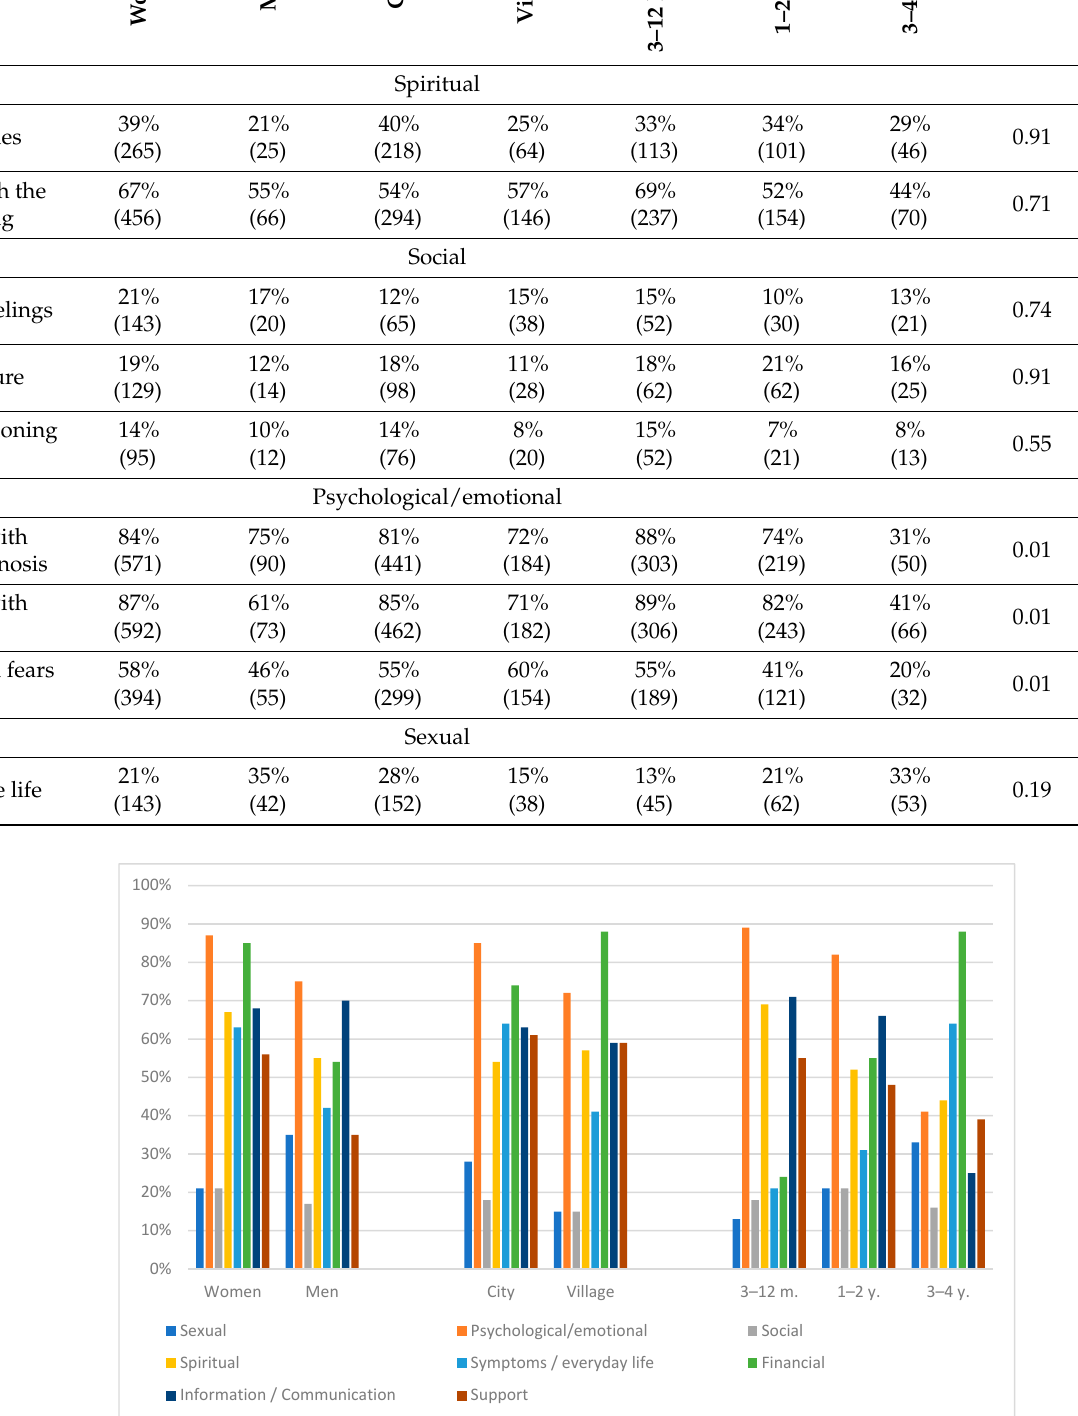
Figure 1. Moderate and high parents’ needs: sex, place of residence, time of illness of the child.